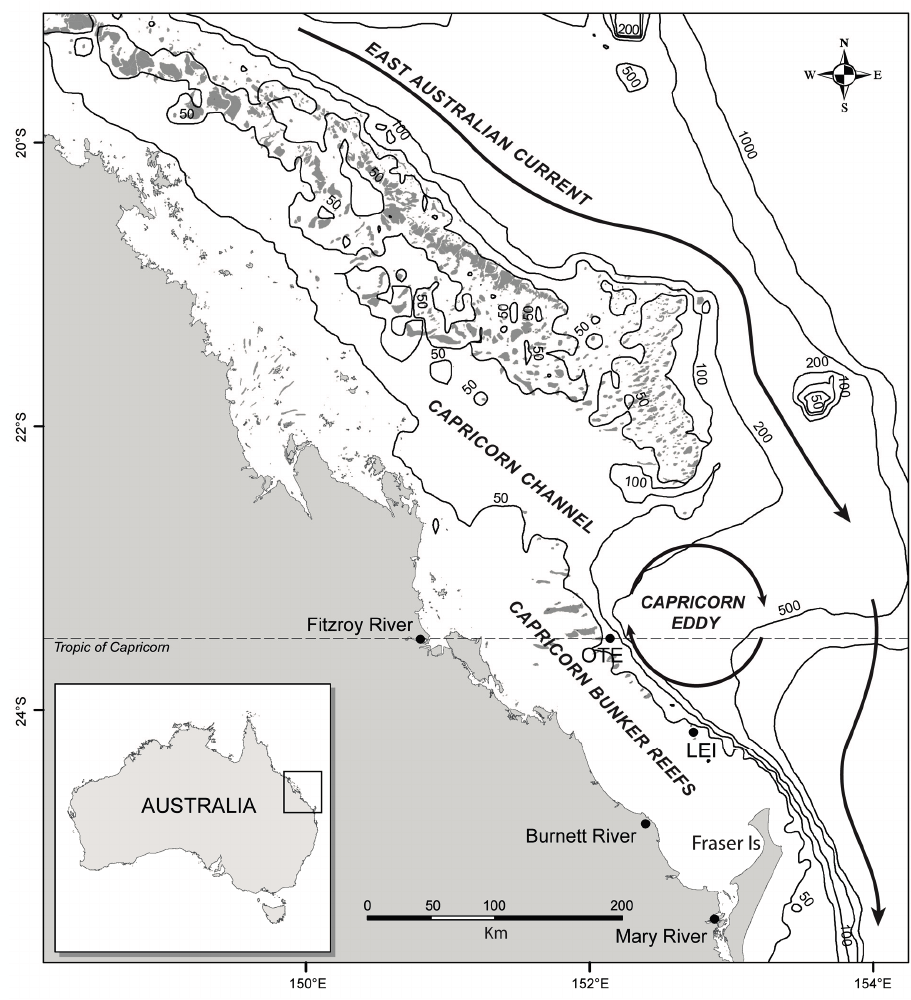
Figure 1. Map of the southern Great Barrier Reef illustrating key bathymetric features, islands and coral reefs, and locations of major river mouths. Dark circular markers close to the shelf edge show the locations of Lady Elliot Island (LEI) and the in-line mooring to the east of One Tree Island (OTE). Modified from